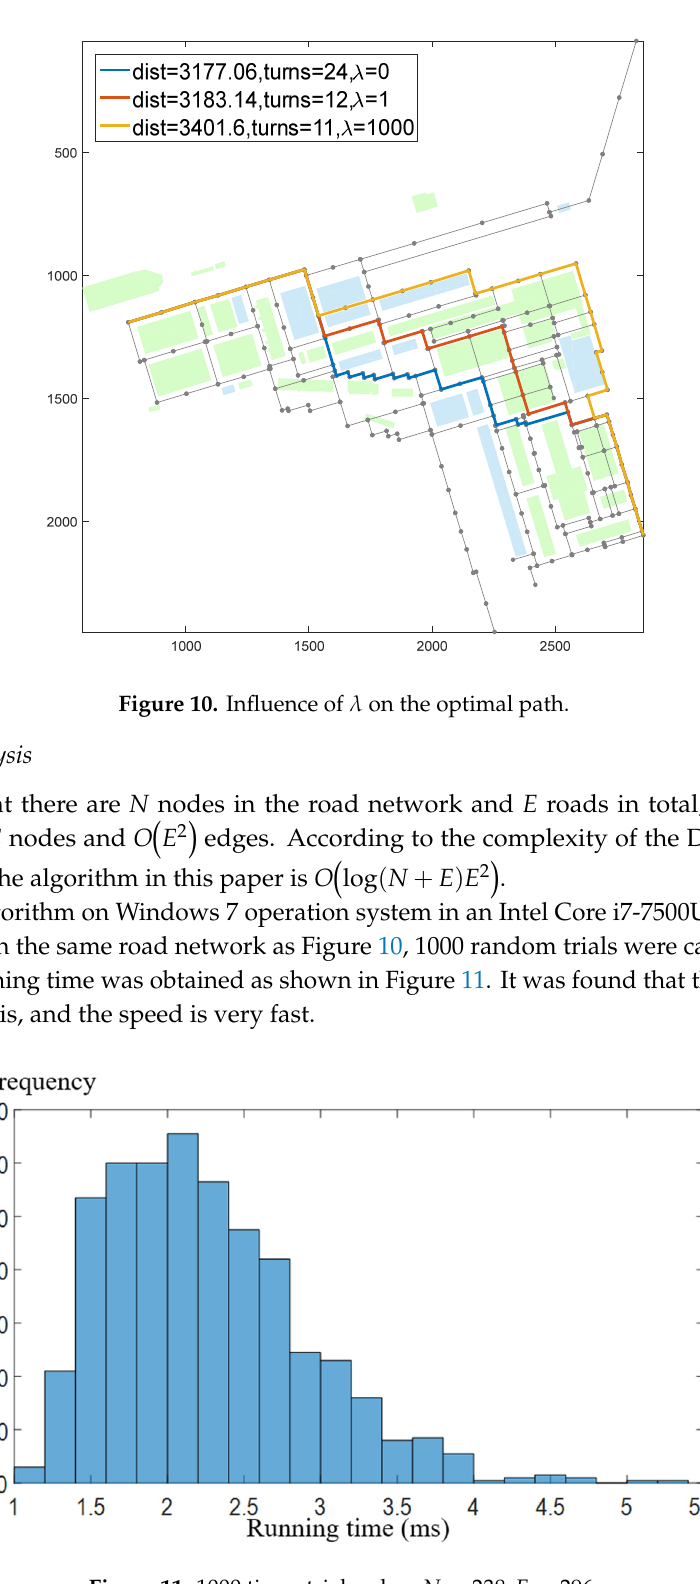
Figure 11. 1000 times trials when N